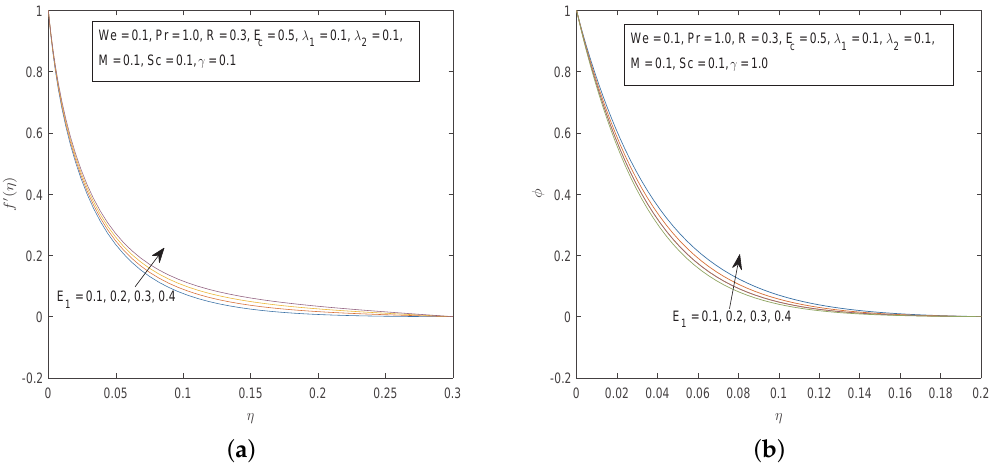
Figure 11. ( a ) Effects of E 1 on f (cid:48) ( η ) and ( b ) Effects of E 1 on φ .